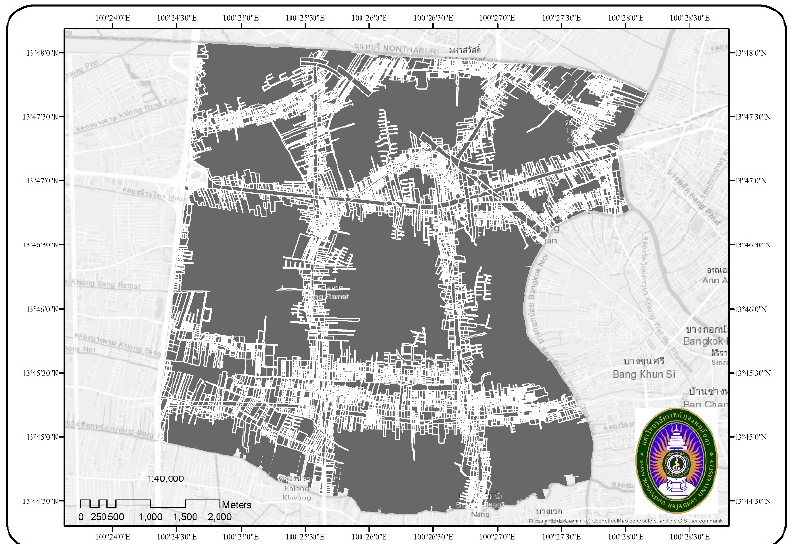
Figure 1. The study area selected 45,032 land parcels from all over the Talingchan district as the experimental data.